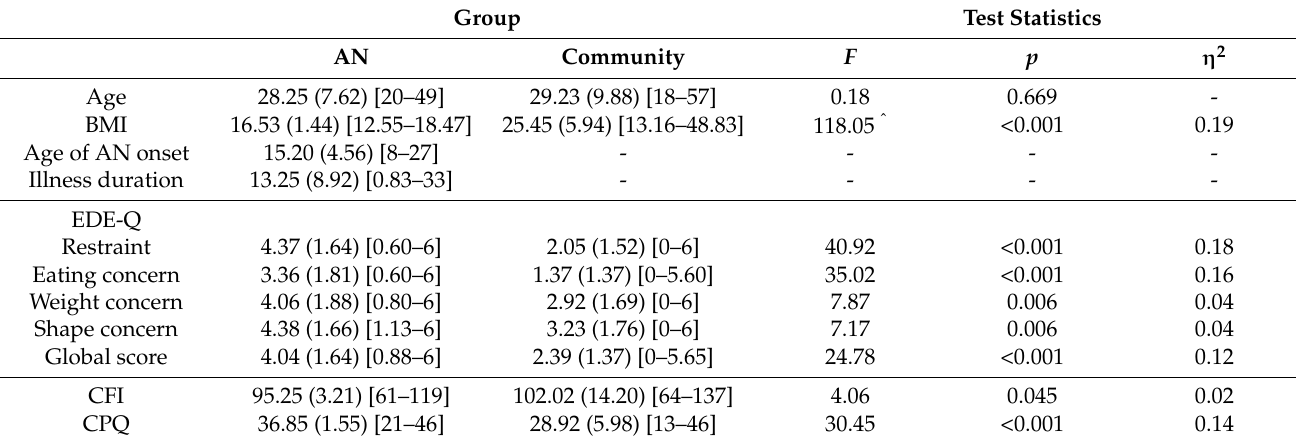
Table 1. Sample characteristics and group